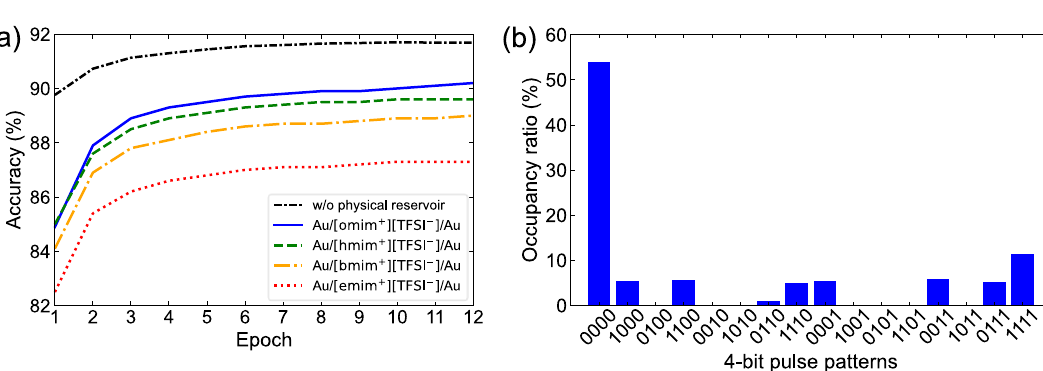
Figure 6. ( a ) Estimated accuracies of image classification using Au/[Rmim + ][TFSI − ]/Au until 12 epochs as a function of alkyl chain length of cations in [Rmim + ][TFSI − ]. Baseline performance of readout layer without physical reservoir is shown as comparison, where the number of weights which can be optimized increases by four times compared to when using the physical reservoir. ( b ) Occupancy ratios of each 4-bit pulse pattern for 6 × 10 6 pulse trains (100 pulse trains × 60,000 training images) used in this